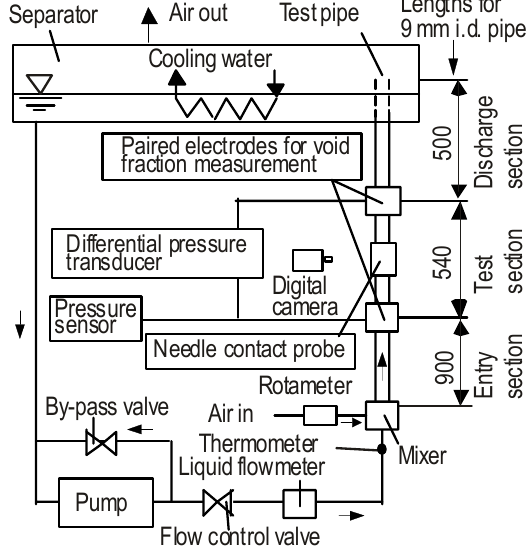
Fig. 1 Apparatus used in this study